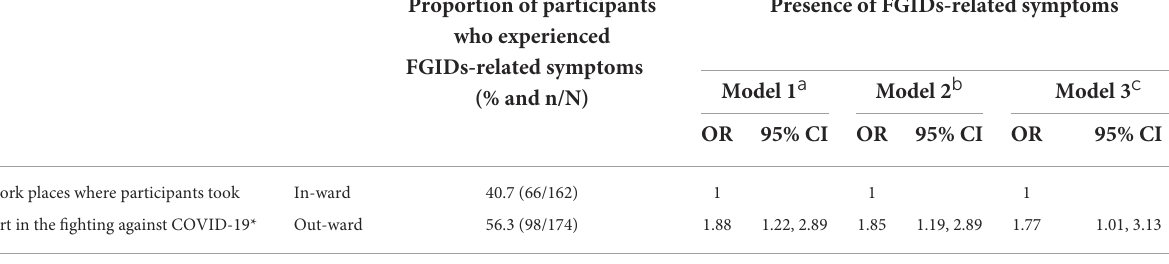
TABLE 3 The association between work places (out-ward/in-ward) and presence of FGIDs-related symptoms among participants in the study.